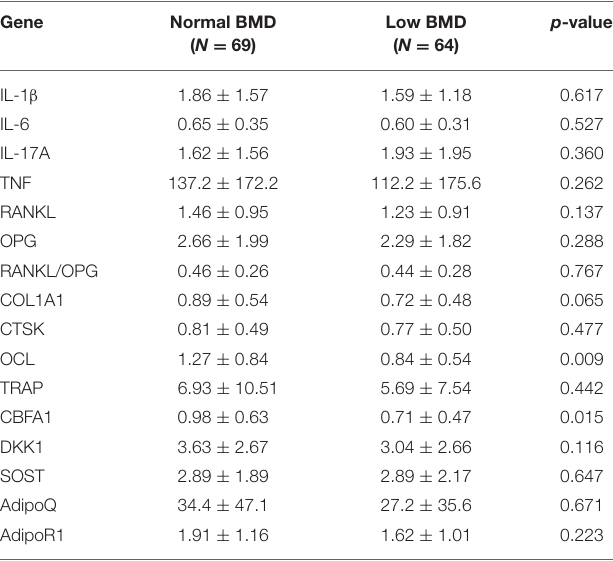
TABLE 4 | Serum levels of atherosclerosis patients with normal and low BMD. TABLE 2 | Gene expression levels in the atheroma plaques of atherosclerosis patients with normal and low BMD. Protein Normal BMD p -value Gene Normal BMD Low BMD ( N = ( N = 69) ( N = 64)